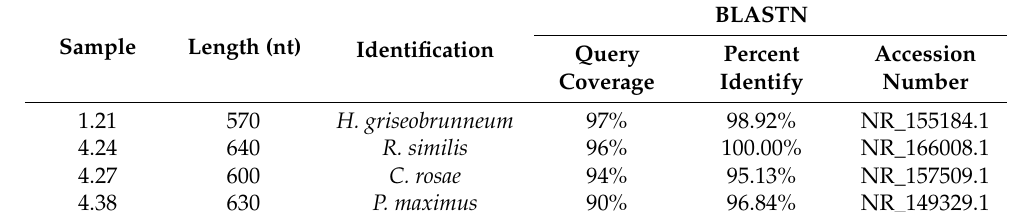
Table 3. Species identified according to BLAST of the NCBI database.